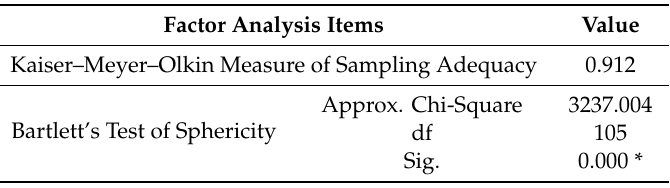
Table 4. Kaiser–Meyer–Olkin (KMO) and Bartlett tests.